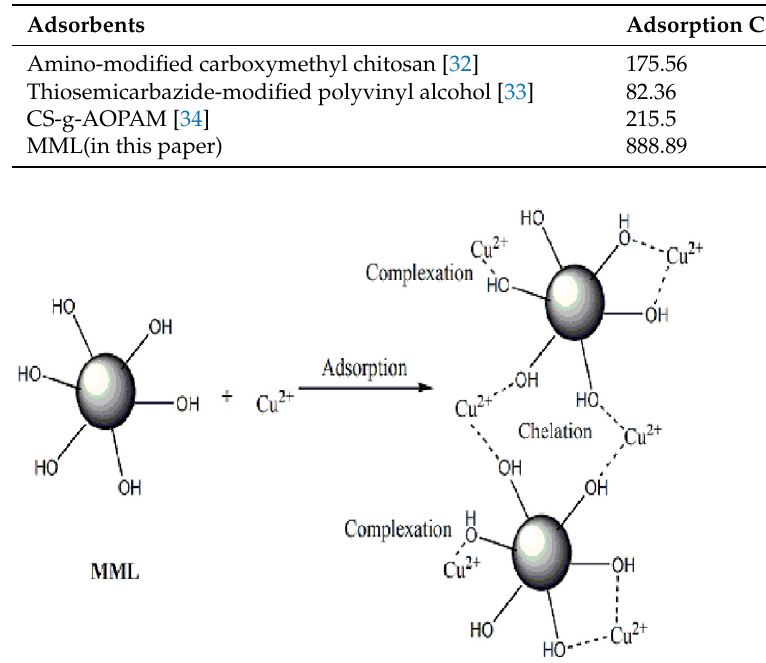
Figure 11. Mechanism of Cu(II) ion adsorption onto MML.